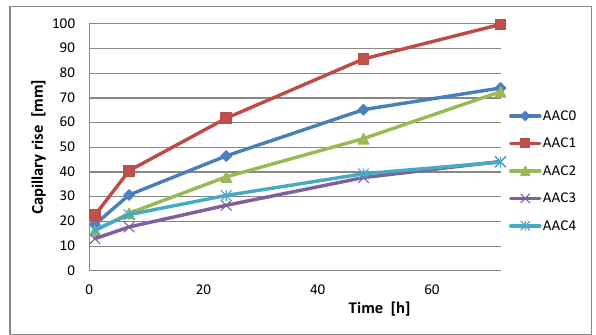
0.05.010.015.020.025.030.0 Figure 4. Influence of gypsum dosage on the drying process of AAC at 22°C from the Figure 4: Influence of gypsum dosage on the drying process of AAC moisture resulting from the production process to the stabilized moisture content at 22 ∘ C from the moisture resulting from the production process to the stabilized moisture